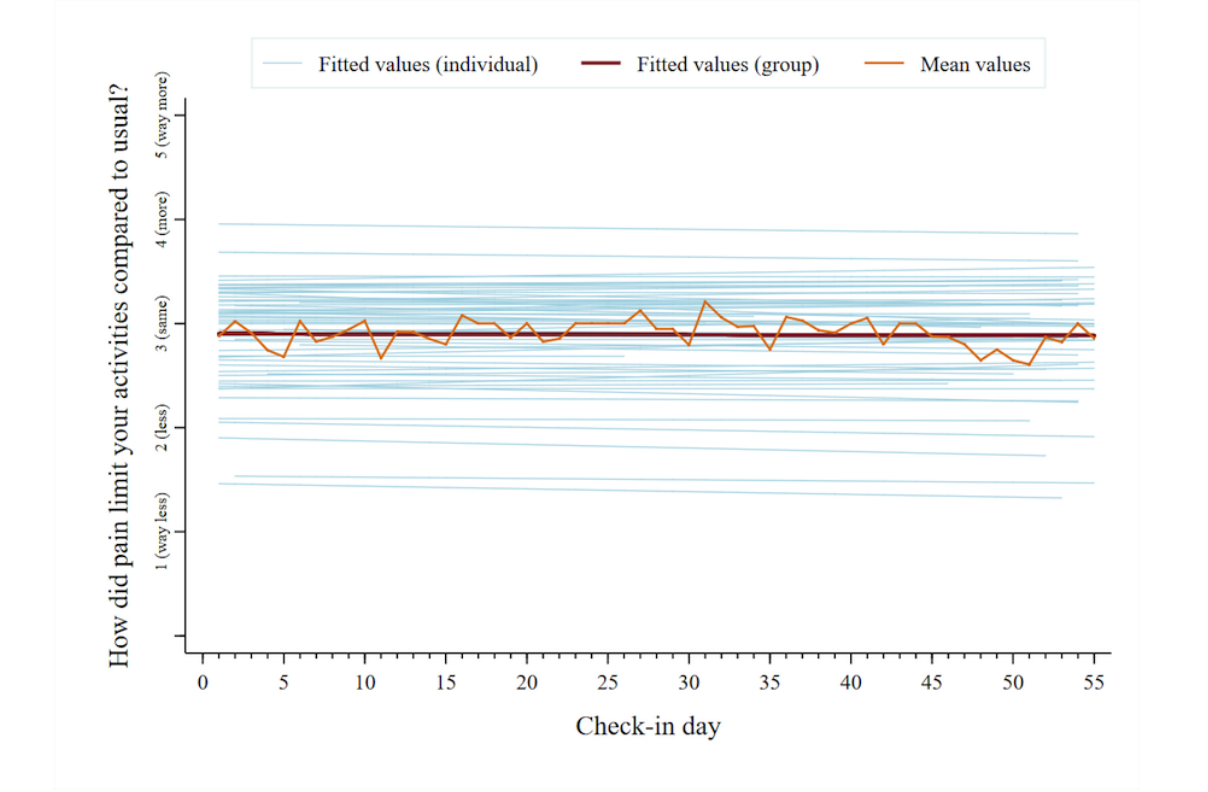
Figure 6. Self-reported pain interference across 55 days using the iCanCope daily